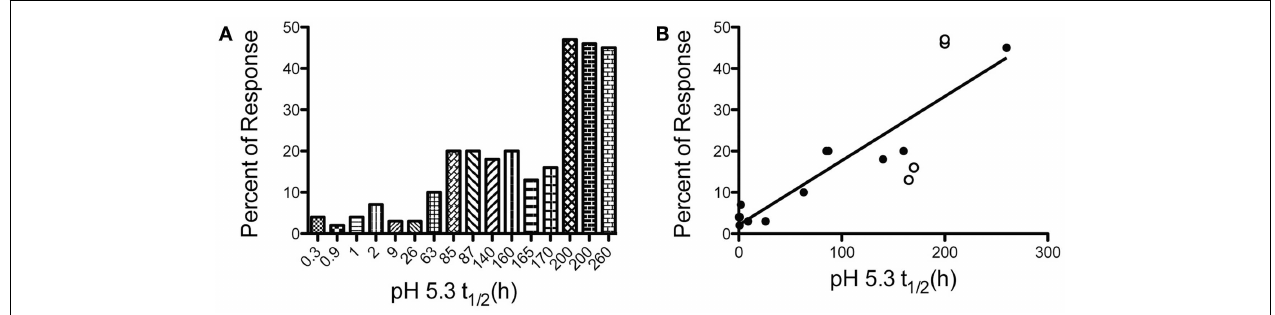
peptide-MHC class II complexes at pH 5.3. (A) To visualize breakpoints in immunodominance (e.g., cryptic, subdominant, dominant) the magnitude of the peptide-specific response of different peptides are presented in order the increasing kinetic stability of the I-A d peptide complex. (B) A near linear relationship is found when between kinetic stability and CD4T cell immunodominance when values in (A) are represented on a linear scale. Filled symbols R 2 = 0.91, with all symbols R 2 = 0.75. Data shown are adapted from previous published studies (5, 8, 9,